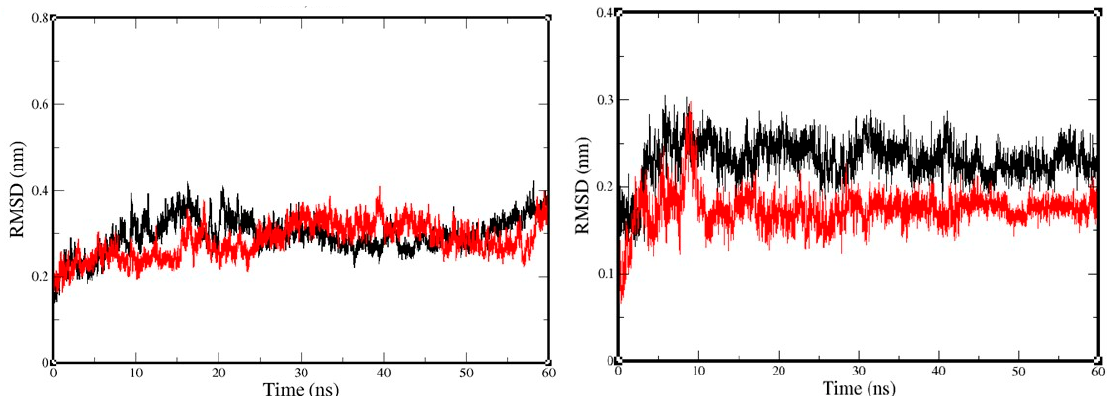
Figure 3. Root-mean-square deviations (RMSDs) of backbone atoms of each complex and of ligands (right plot). Black, NuBBE-1970–NSP15 complex; red plot, NuBBE-242–NSP15.